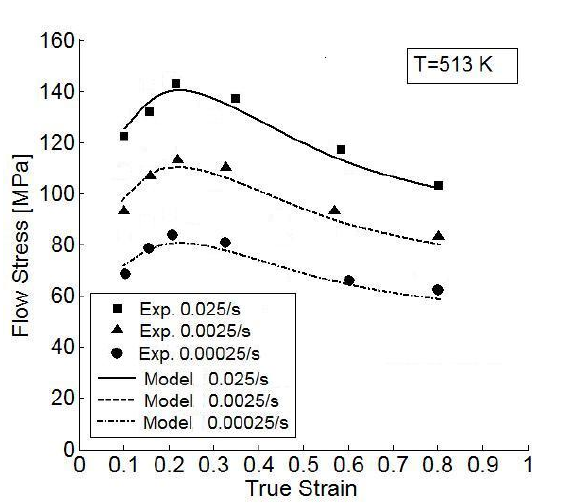
Figure 9: Predicted and experimental data at temperature of 493 K and different strain rates.